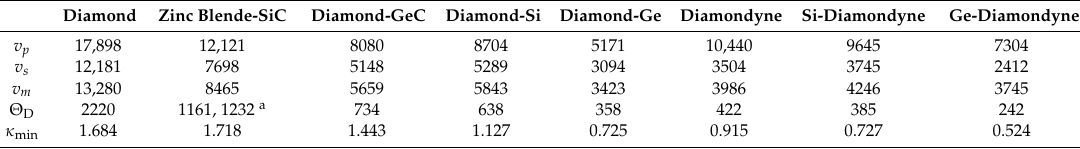
Table 2. The compressional, shear and mean elastic wave velocity ( v s , v p , v m in m / s), and the Debye temperature ( Θ D in K) of diamond, zinc blende-SiC, diamond-GeC, diamond-Si, diamond-Ge, diamondyne, Si-diamondyne and